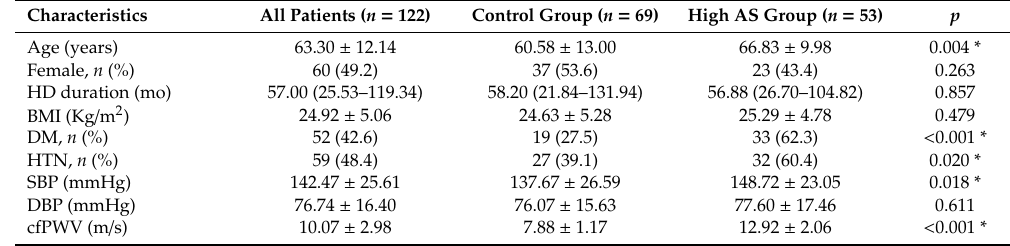
Table 2. Clinical characteristics of the HD patients in high AS and control